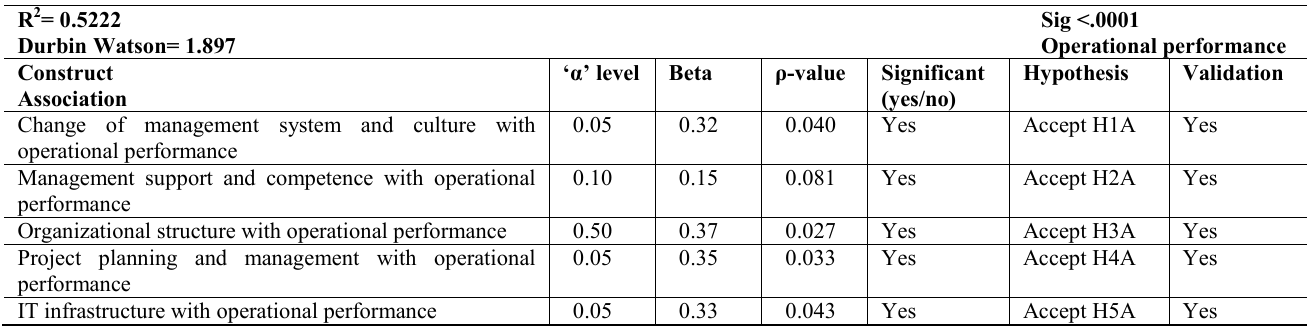
Table 4: Testing the hypotheses a. Step 1: Regression between mediator and independent variables R 2 =